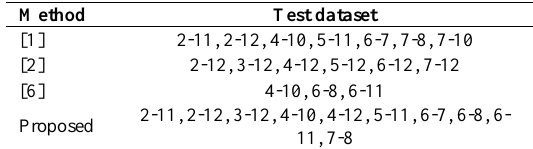
Table 1. Test Dataset in Our Evaluation and Previous